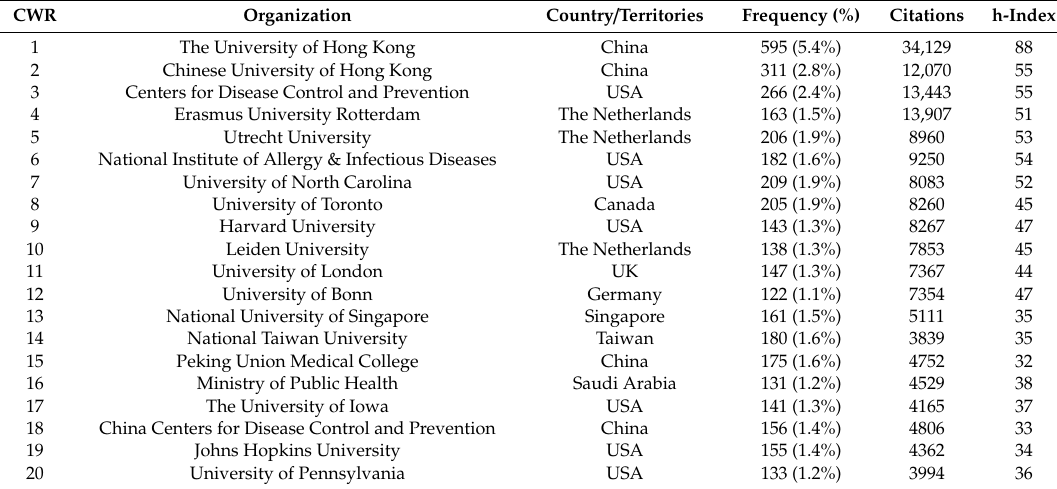
Figure 4. Co-authorship network of organizations. (Note: the size of a circle is in proportion to the number of documents of the organization, the color of a circle corresponds to the year, and the thickness of the lines is proportional to the cooperation frequency). Table 2. Top 20 institutions in the field of coronavirus research.